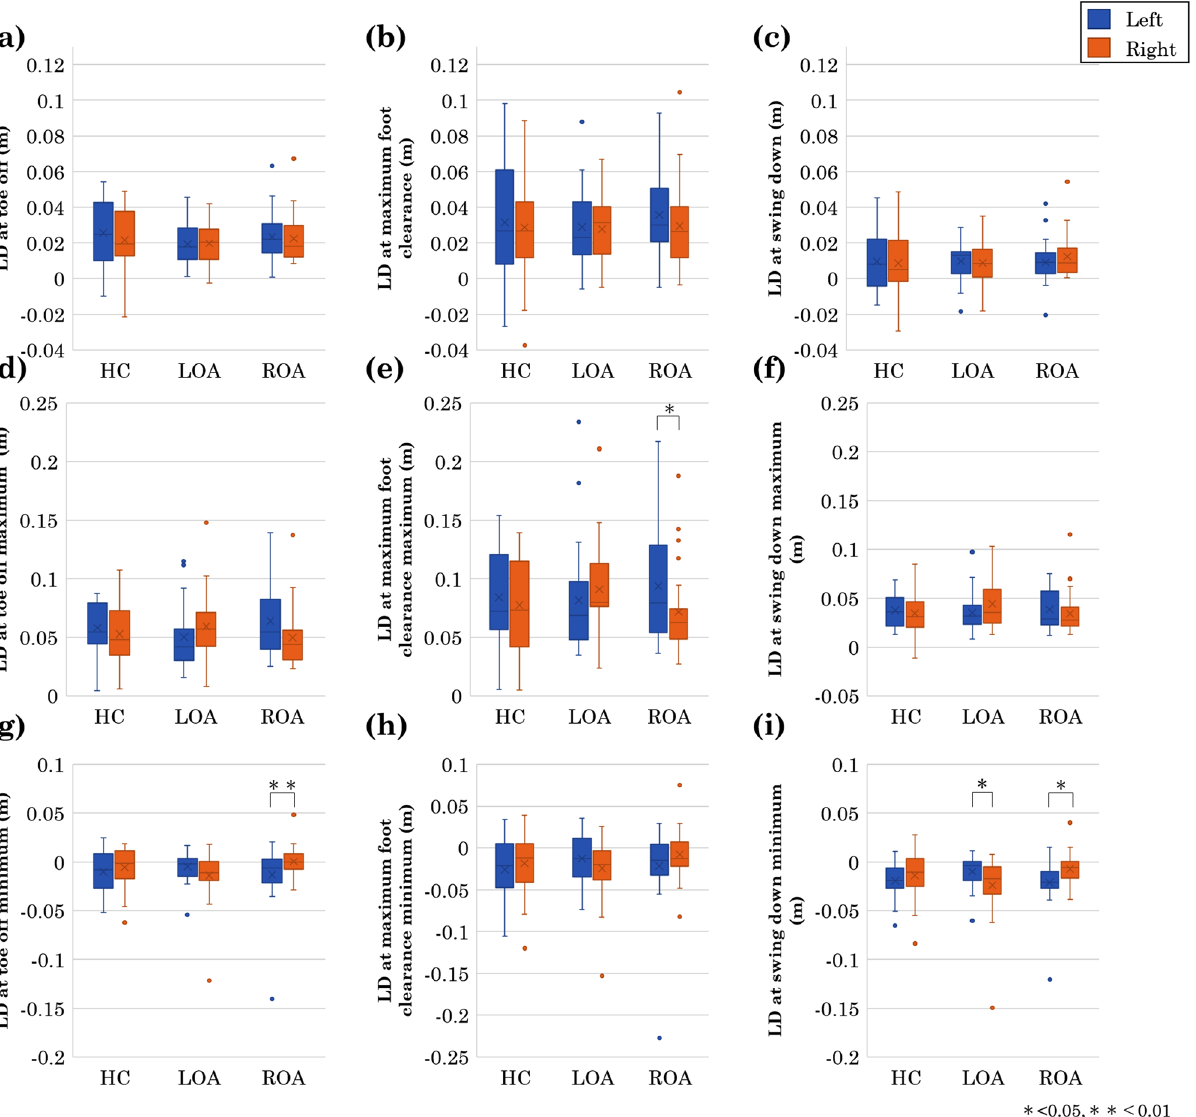
Figure 4. All swing phase of ( a ) lateral distance (LD) at toe off, ( b ) LD at maximum foot clearance, ( c ) LD at swing down, ( d ) LD at toe off maximum, ( e ) LD at maximum foot clearance maximum, ( f ) LD at swing down maximum, ( g ) LD at toe off minimum, ( h ) LD at maximum foot clearance minimum, ( i ) LD at swing down minimum. Blue is the left leg, orange is the right leg, and error bars indicate the participant’s SD. From left to right: healthy control (HC), left hip osteoarthritis (LOA), right hip osteoarthritis (ROA). * indicates significance at p < 0.05 and ** indicates significance at p < 0.01 those in the unaffected side. There was no difference in the mean, maximum and minimum LDs of the foot during the swing phase between patients with hip OA and HCs in toe off and maximum foot clearance and swing down. However, the unaffected sides were located more medially than the affected sides at the swing down minimum. For the temporal gait parameters, the speed of patients with hip OA was significantly slower, and their stride duration, stance duration, and swing duration were significantly longer in the patients with hip OA than those in the HCs. In addition, in patients with hip OA, the speed, and stance duration were significantly decreased on the affected side compared to those on the unaffected side; and the swing duration was significantly longer on affected side than that on the unaffected side. However, there was no significant difference in stride duration between the affected and unaffected sides. Some of the results basically supported previous studies. The results for stride length, speed, stance duration, and swing duration were consistent with gait characteristics of individuals with hip OA in the previous study 33 . On the other hand, the results for the speed of each stride and the maximum foot clearance differed form those in some previous studies. In measuring the speed of each stride in the left and right lower limbs, there was a significant difference in the stride speed between the affected and unaffected side in the patients with LOA and ROA. This lower speed in the affected side would be caused by a decrease in hip moment 24 and pain, resulting in